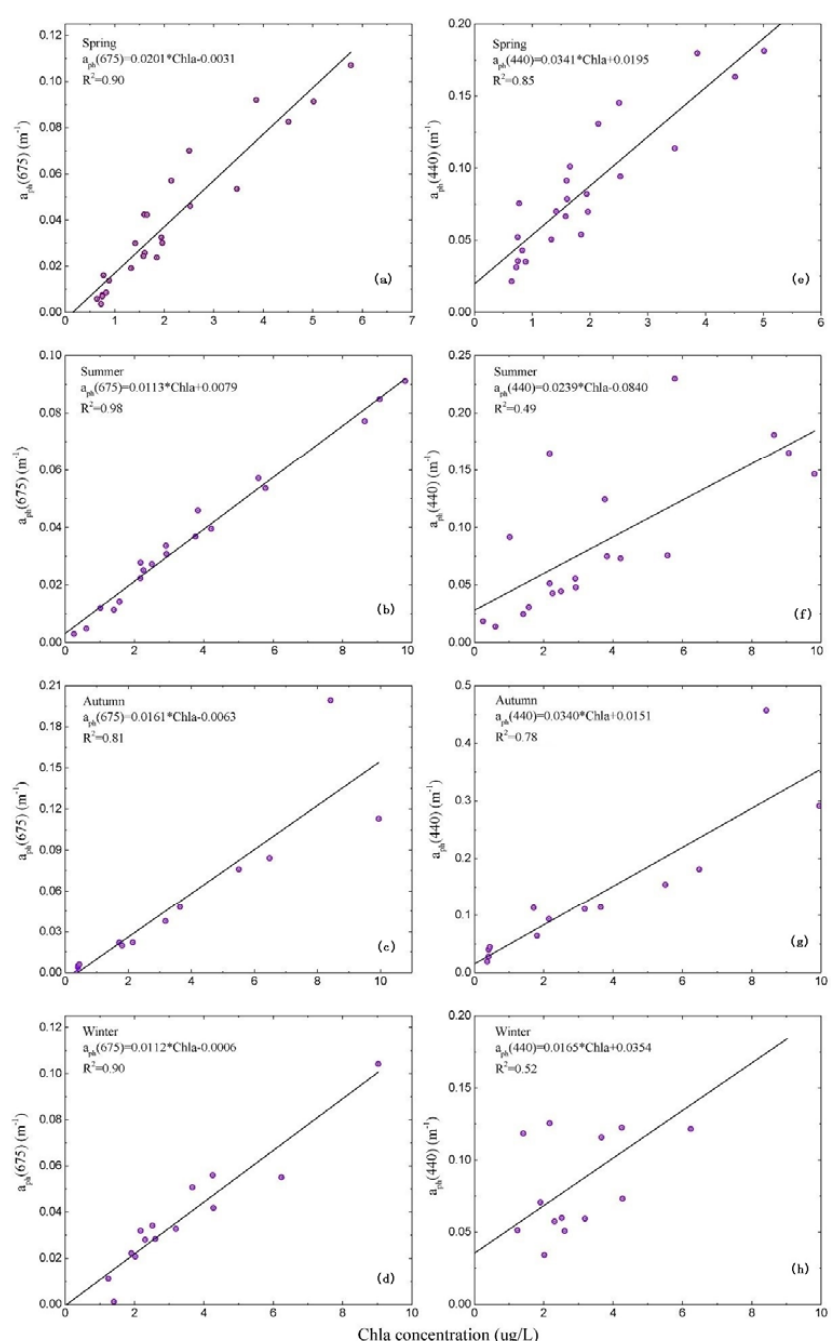
Figure 12. Correlations between a ph ( 440 ) and Chl -a concentration ( a – d ); and between a ph ( 675 ) and Chl ‐ a concentration ( e ‐ h ) for each season.